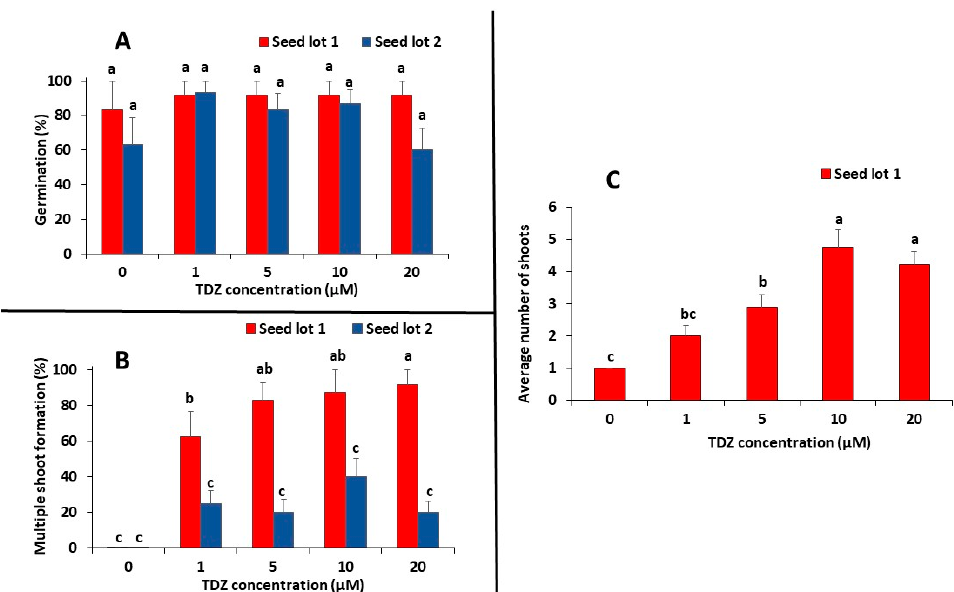
Figure 1. Effect of different thidiazuron (TDZ) concentrations (0, 1, 5, 10, 20 µM) on seed germination ( A ), percentage of seeds with multiple shoot formation ( B ) and average number of shoots per germinated seed ( C ) of Lupinus rivularis for two different seed lots. Shoots formed from seed lot 2 showed necrosis and died within a few weeks. Data represents mean ± standard error from four replications, 10 seeds per replication. Means followed by different letters are significantly different according to Tukey Test ( p < 0.05). Agronomy 2021 , 11 , x FOR PEER REVIEW